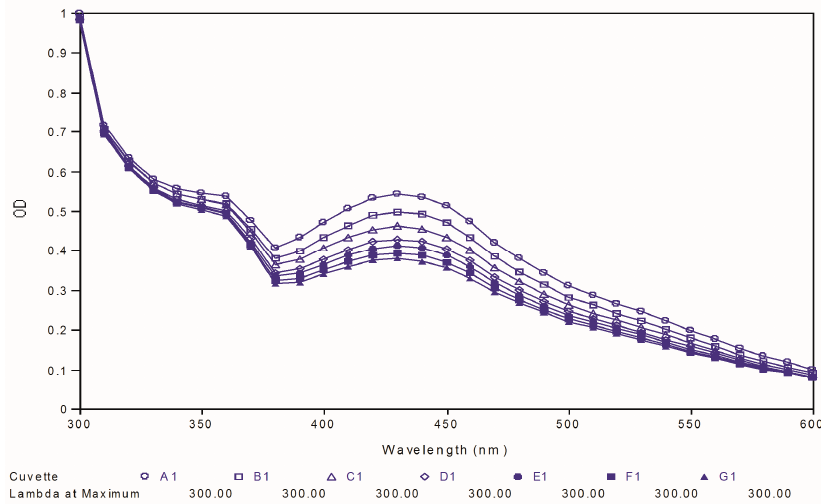
Figure 8. Ultraviolet-visible absorption spectra of curcumin.